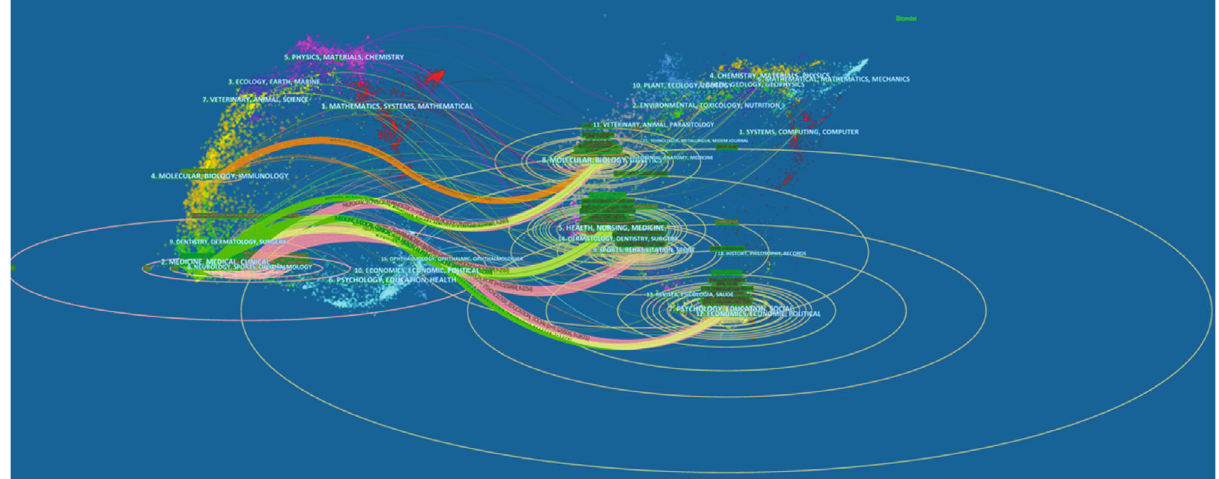
Figure 7: The dual-map overlay of journals related to on neuropathic pain rehabilitation research.